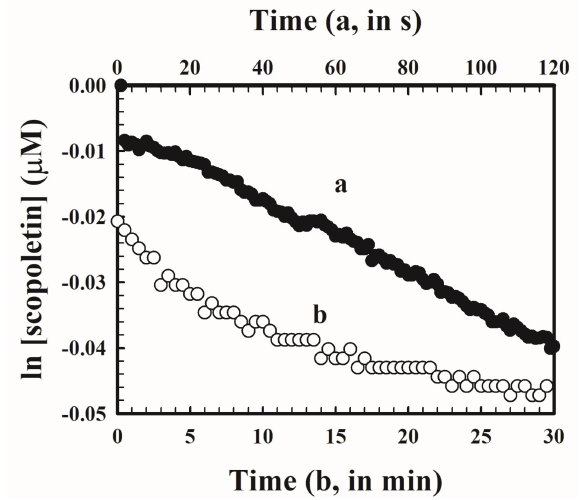
Figure 4. The time course of change in the natural logarithm of scopoletin concentration (in µ M) by photobleaching in two fluorometers. (a) : Hitachi Model F-7000 fluoresence spectrophotometer, upper scale (in seconds); (b) : Turner Model 10-AU-005-CE filter fluorometer, lower scale (in (cid:35)